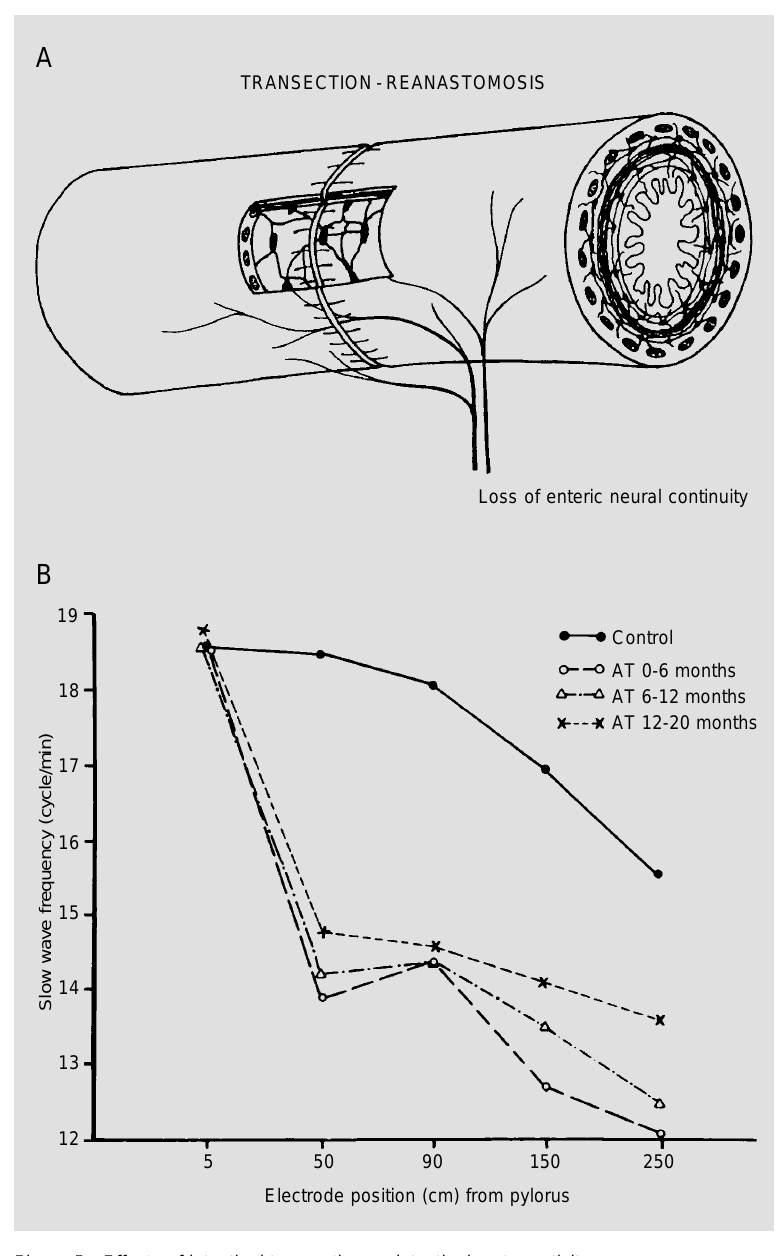
Figure 5 - Effects of intestinal transection on intestinal motor